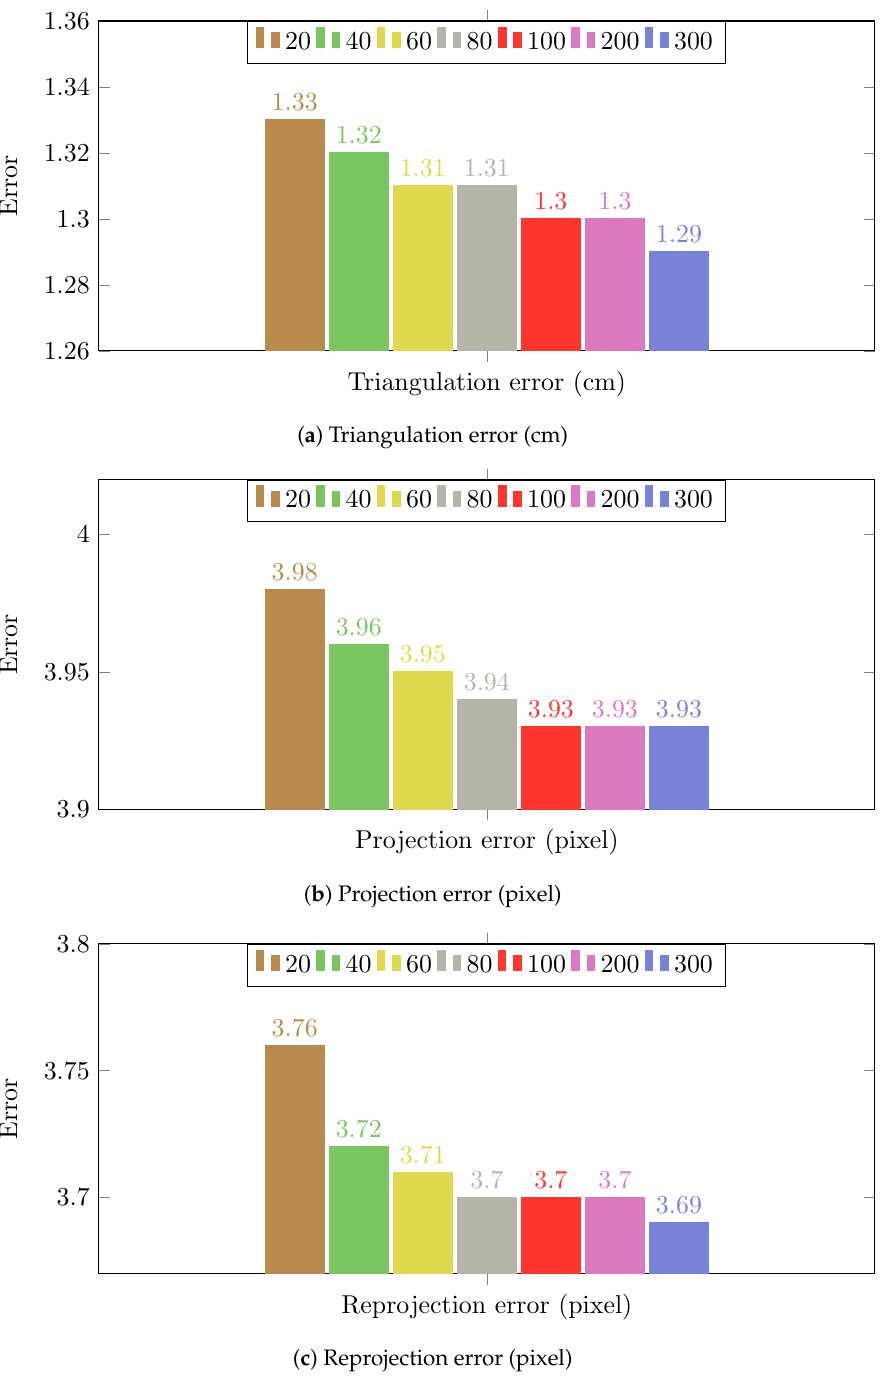
Figure 2. The calibration results of the proposed method on Camera Network 1 (multiple people walking in an empty room) by using different number of random locations. Each location yields two calibration samples (top and